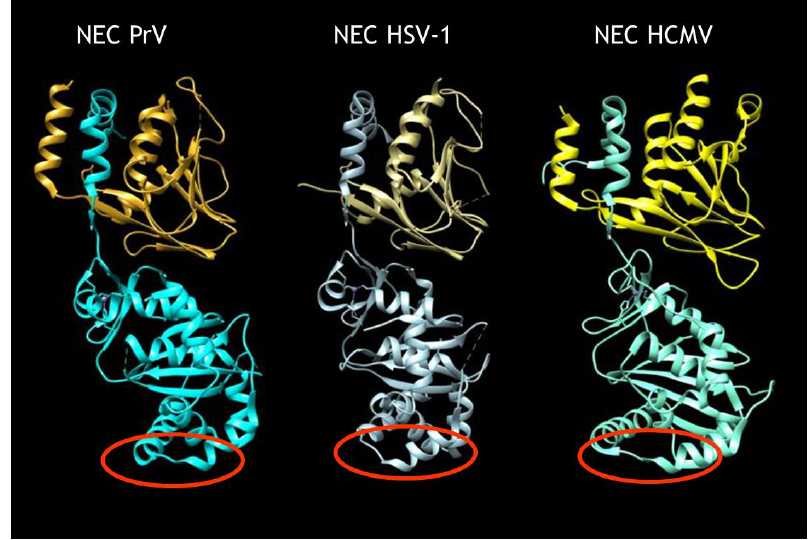
Figure 1. Structure of herpesvirus nuclear egress complex (NEC). Structures of the heterodimeric NEC of the alphaherpesviruses pseudorabies virus (PrV) [11,12] and herpes simplex virus 1 (HSV-1) [11] as well as of the betaherpesvirus human cytomegalovirus (HCMV) [13,14]. The N-terminal extended α-helix of pUL31 ( bottom ) inserted into the groove in pUL34 ( top ) is apparent. In the HSV-1 NEC structure, the second pUL34 α-helix lining the groove has not been resolved. Red circles denote putative capsid-interaction domains.